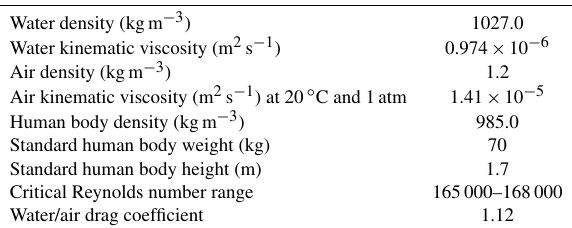
Table 2. Parameters used to solve the force balance equation about the person in